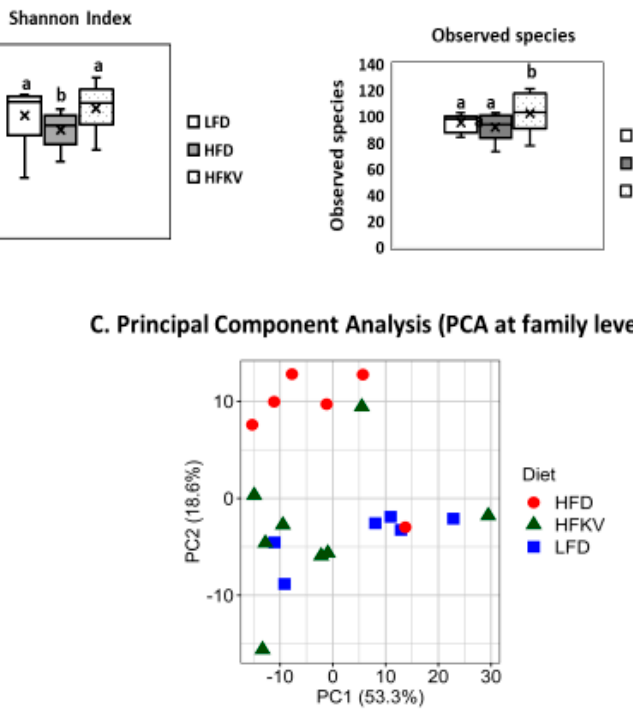
Figure 1. Alpha and beta diversity measures. ( A ) Alpha diversity plots. Boxes represent the interquartile range between the first and third quartiles. The horizontal line inside the box defines the median and the “x” represents the mean. Whiskers represent the lowest and highest values within 1.5 times the interquartile range between the first and third quartiles, respectively. The dots outside the box represent outliers. All diversity indices were higher in the HFKV group compared to both LFD and HFD ( p < 0.05). The letters ‘a’ and ‘b’ denote statistically significant values at p < 0.05; ( B ) The rarefaction curve reached a summit after 53,037 sequences for all treatment groups, as shown by the alpha diversity (Shannon analysis); ( C ) Principal component analysis (PCA) score plot of beta diversity. The different colors represent different diet groups, and the closer data points represent similarity in microbial composition (Pseudo F = 4.11; p = 0.001).